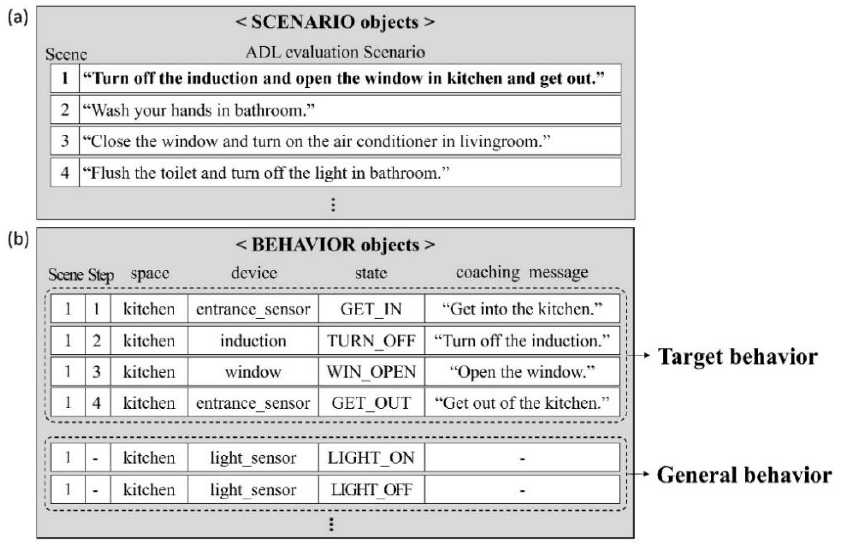
Figure 9. ( a ) ADL evaluation SCENARIO objects. ( b ) BEHAVIOR objects related to Scenario_1.